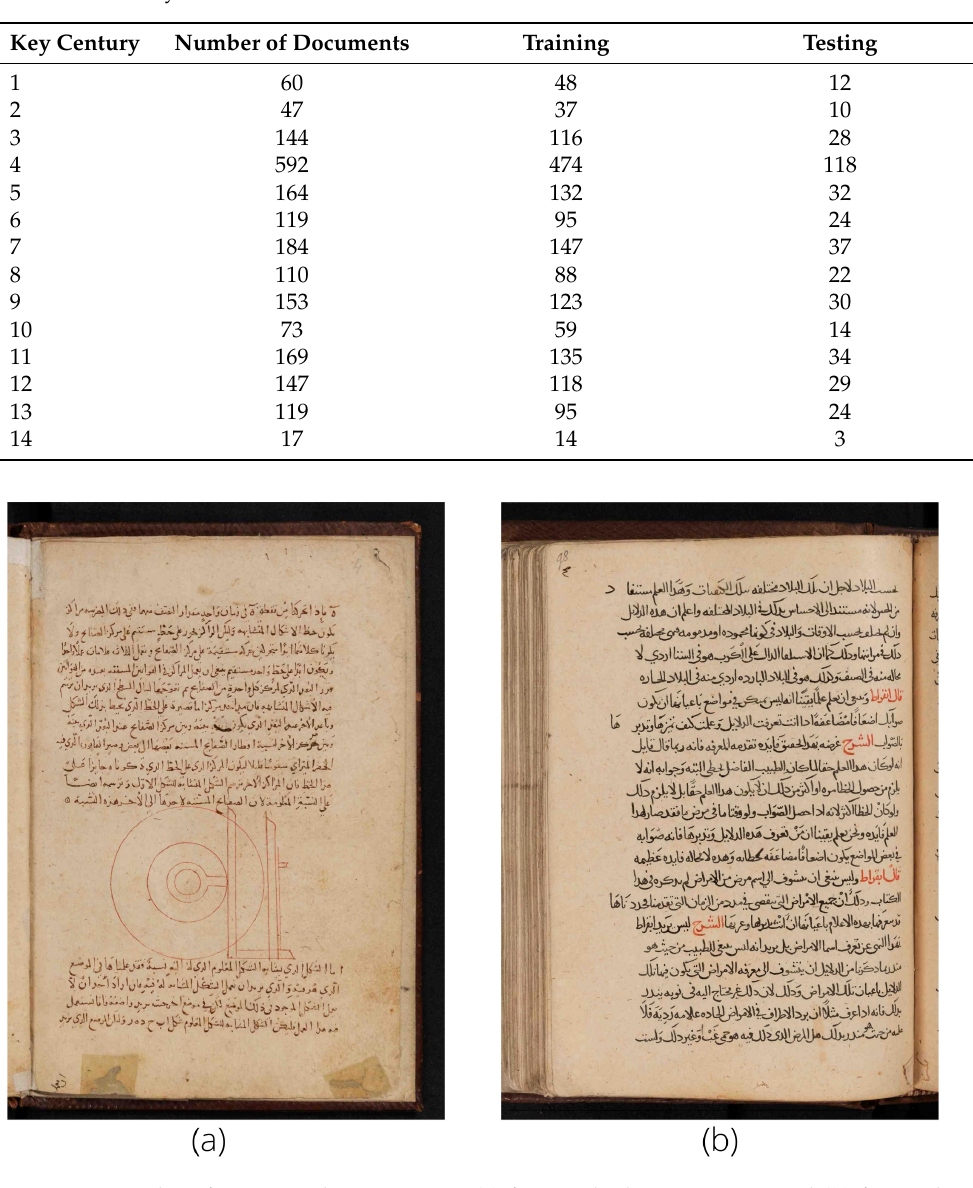
Figure 3. Samples of KERTAS dataset images ( a ) from 3rd Islamic century, and ( b ) from 7th Is- lamic